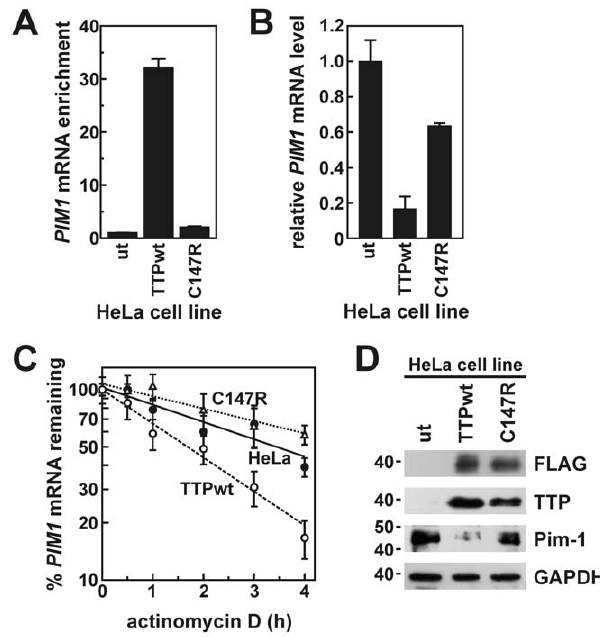
Figure 4. Functional association of TTP with PIM1 mRNA in HeLa cells. (A) RNP-IP experiments were performed using control IgG or anti-FLAG antibodies and lysates from untransfected HeLa/Tet-Off cells (ut) or stable clonal lines expressing FLAG-TTPwt or FLAG-TTP C147R as described in ‘‘Materials and Methods’’. Immunoprecipitated material was then screened for PIM1 mRNA by quantitative real-time RT- PCR and normalized to GAPDH mRNA (mean 6 SD of three reactions). Independent replicate experiments yielded similar results. (B) Relative levels of PIM1 mRNA were measured in untransfected versus FLAG- TTPwt- or FLAG-TTP C147R-expressing HeLa cells. Bars represent the mean 6 SD of quadruplicate qRT-PCR reactions normalized to GAPDH mRNA. (C) The decay kinetics of PIM1 mRNA was measured in HeLa cell models using actD time course assays as described in Figure 2. mRNA half-lives calculated from independent replicate experiments are provided in the text. (D) Western blot analyses using antibodies targeting specified proteins in HeLa/Tet-Off cell models, with positions of molecular weight markers (in kDa) shown at left.